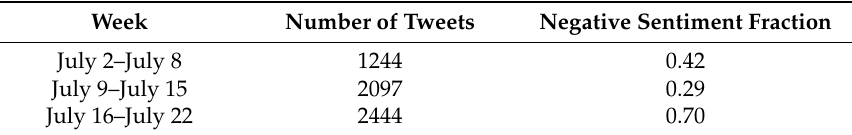
Table 2. Number of tweets in each week and corresponding negative sentiment